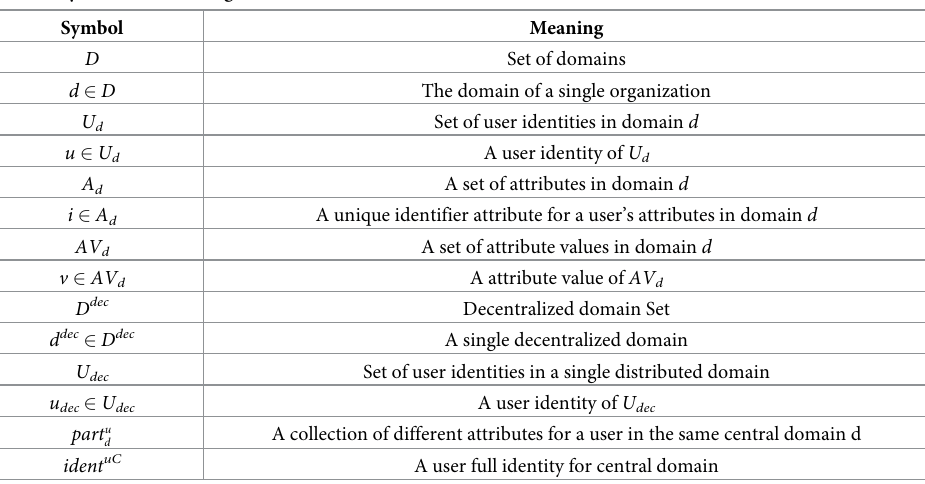
Table 2. Symbol and